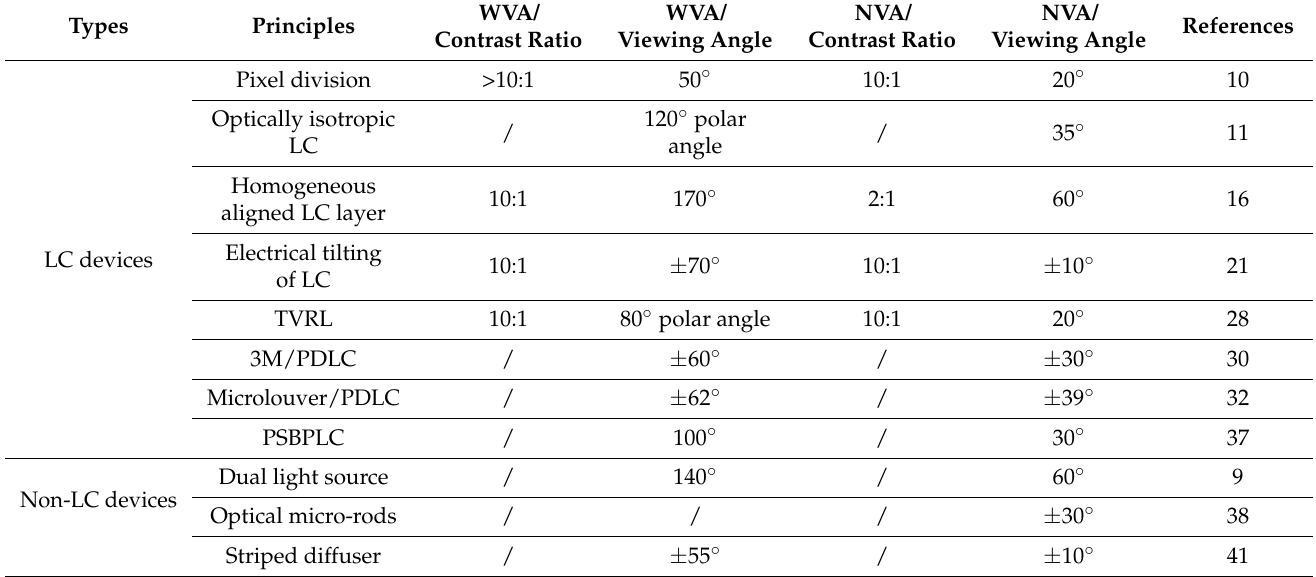
Table 1. Comparison of the performances of various LC and non-LC devices.